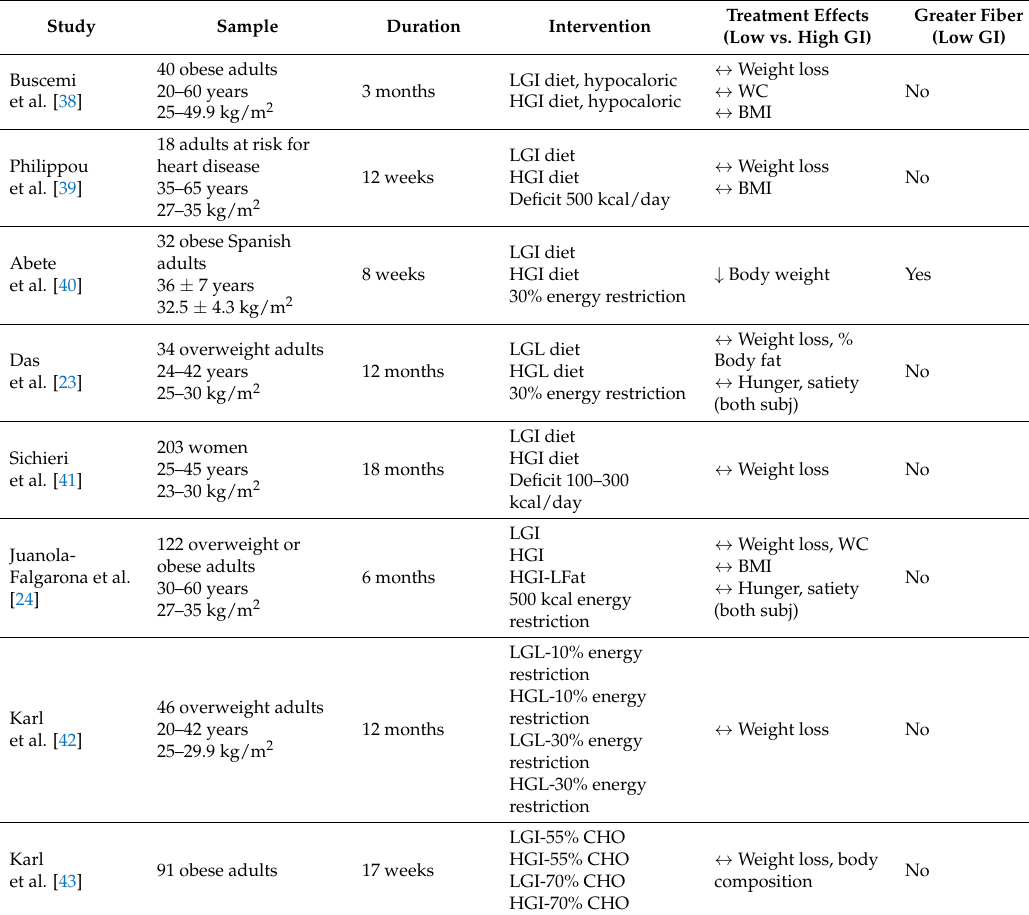
Table 4. Intervention studies with parallel design assessing the effects of chronic intake of diets with different GI on body weight 1